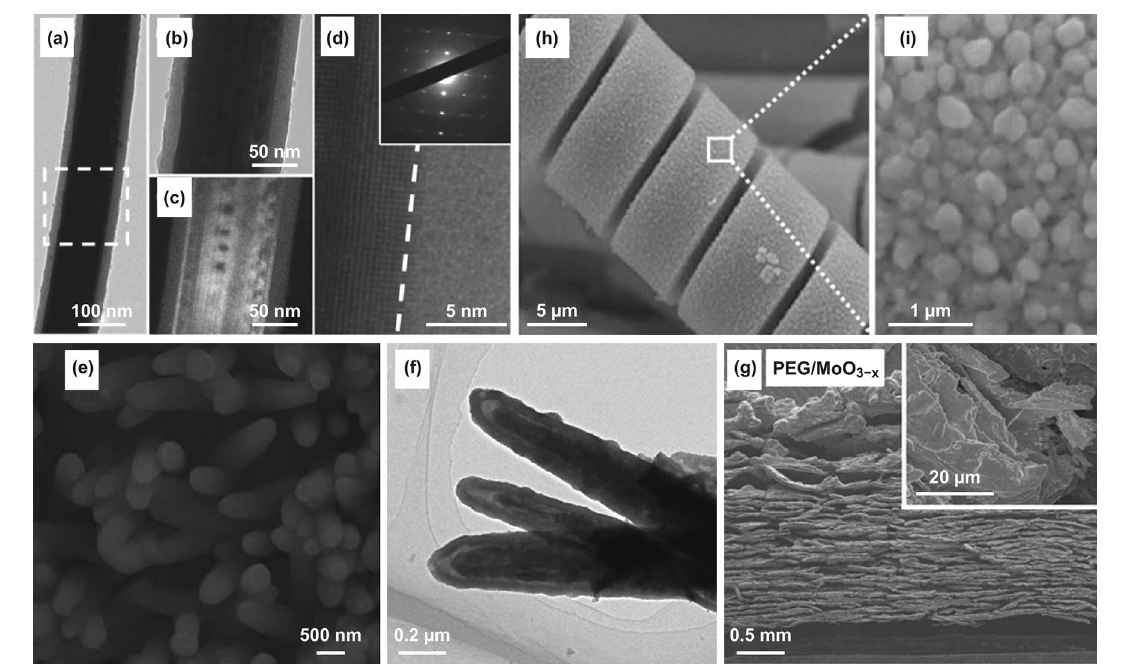
Fig. 23 a – c TEM images of a MoO 3− x ‑coated WO 3− x nanowire: a , b bright and c dark fields. d High‑resolution TEM image of a MoO 3− x ‑coated WO 3− x nanowire. Inset: Selected electron diffraction pattern of WO 3− x . e An SEM and f TEM images of ZnO@MoO 3 core–shell structure. g A SEM image of MoO 3− x film deposited on an exfoliated graphite substrate. h , i SEM images of the helical porous MoO 2 with dif‑ ferent magnifications. Adapted from a – d Ref. [226], e , f Ref. [227], g Ref. [228], h Ref. [229] with